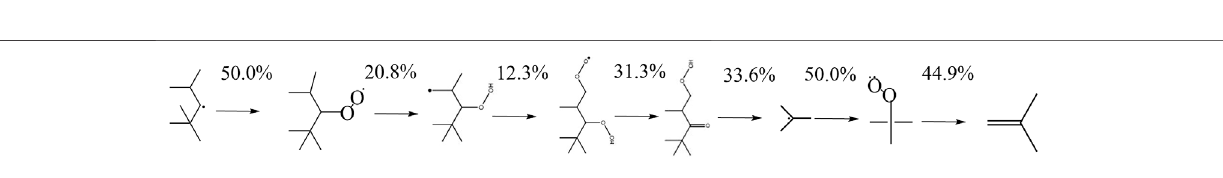
FIGURE 13 | Reaction pathway of b-iso-octyl-radical to iso-butene derived by the mechanism of Atef et al. (2017) at 623 K and 20 bar.